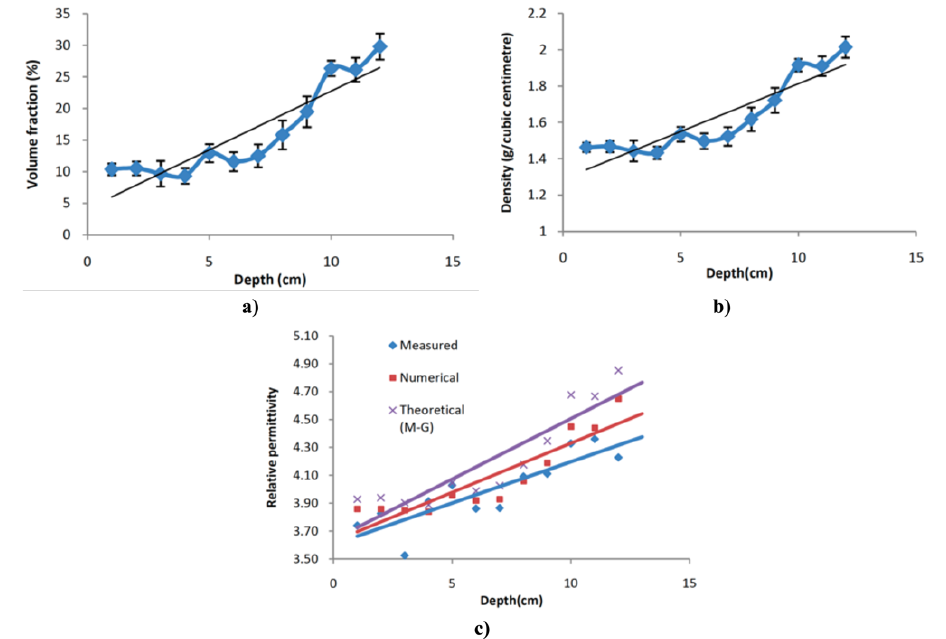
Figure 44. Properties vs. depth in Al 2 O 3 /epoxy composites with field-grading properties: ( a ) volume fraction, ( b ) density, and ( c ) relative permittivity. © 2021 IEEE. Reprinted, with permission, from